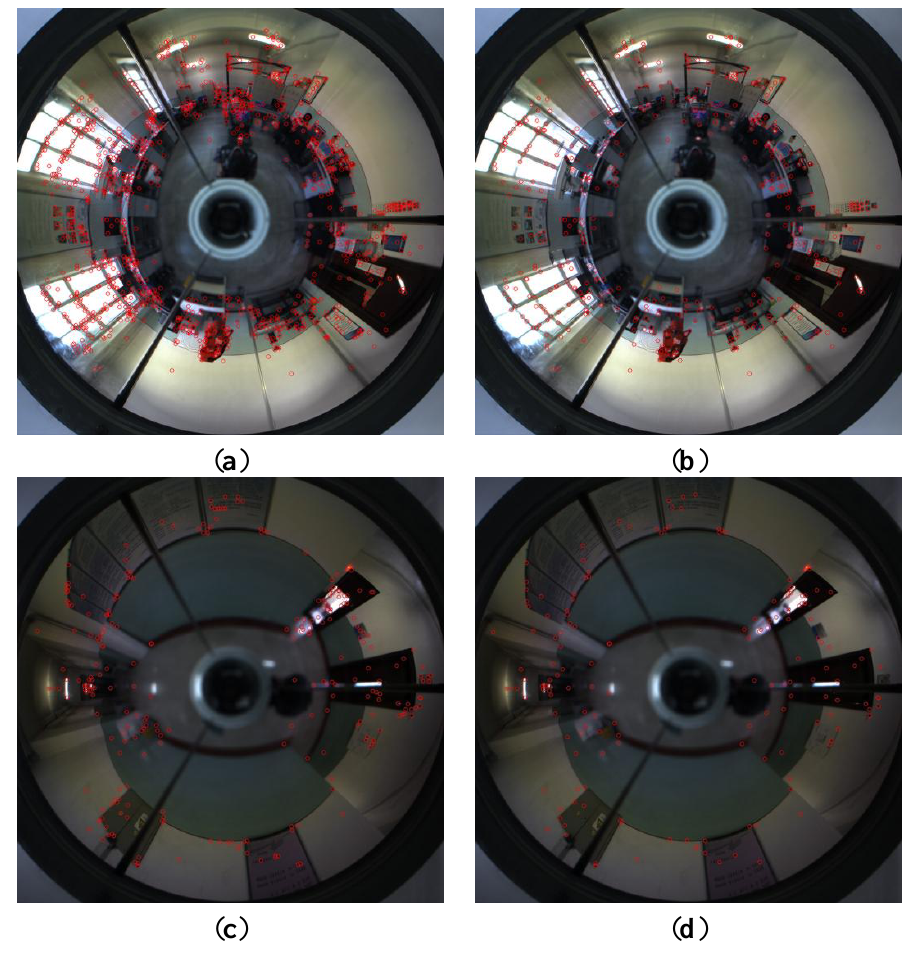
Figure 5. The distribution of features. The red circles denote feature positions. ( a , c ) show the non-uniform distribution of features extracted by the standard SURF; ( b , d ) show the uniform distribution of features extracted by the proposed